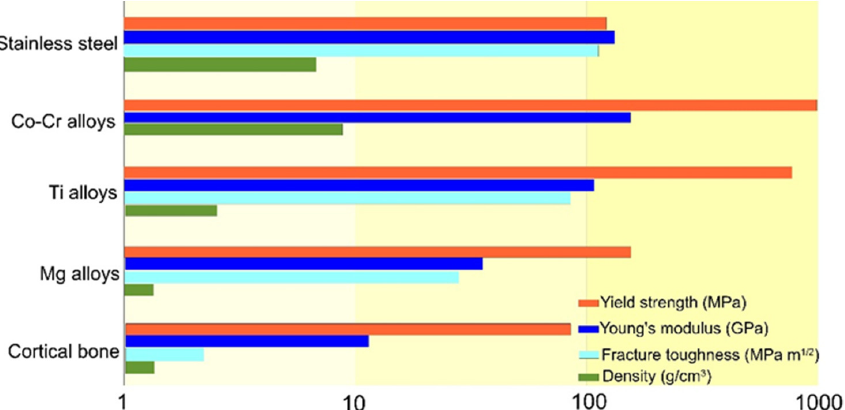
Figure 3. Comparison of the elastic moduli, density, yield strength and fracture toughness of different metallic biomaterials compared to those values in the cortical bone.